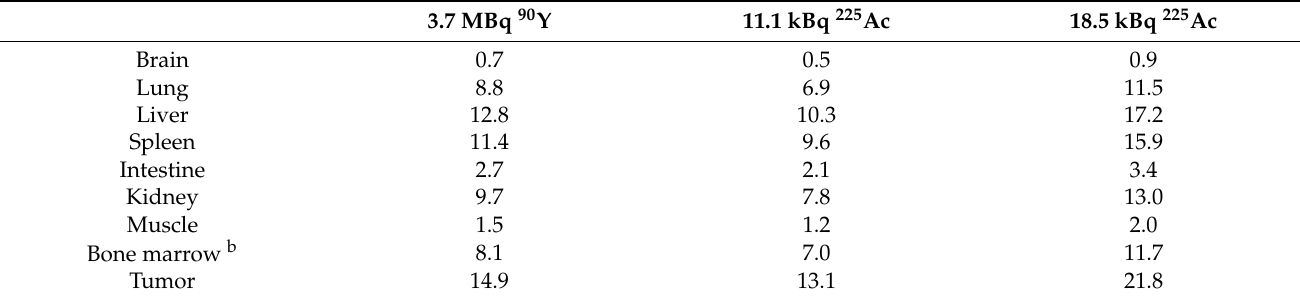
Table 5. Estimated absorbed doses (Sv) from the treatment dose of 90 Y- and 225 Ac-labeled NZ-16 using radiation weighting factors a